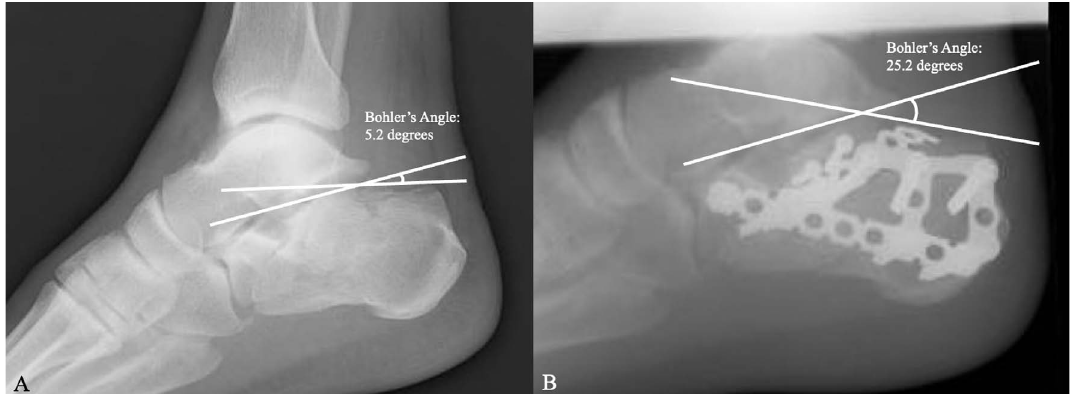
Figure 2. (A) Preoperative lateral foot radiograph of a comminuted, joint depression-type calcaneal fracture. Bohler ’ s angle measured 5.2 degrees through intersecting lines tangential to the superior tuber and the superior aspect of the posterior facet, and the superior aspect of the posterior facet and the anterior calcaneal process. In (B) a postoperative lateral foot radiograph is shown status post open reduction with internal fi xation with a 3.5 mm lateral calcaneus plate with an additional two 2.7 mm lag screws underneath the posterior facet. There is restoration of Bohler ’ s angle measuring 25.2